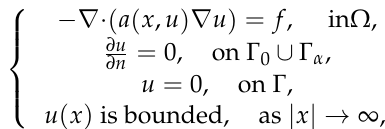
Figure 1. The illustration of domain Ω .